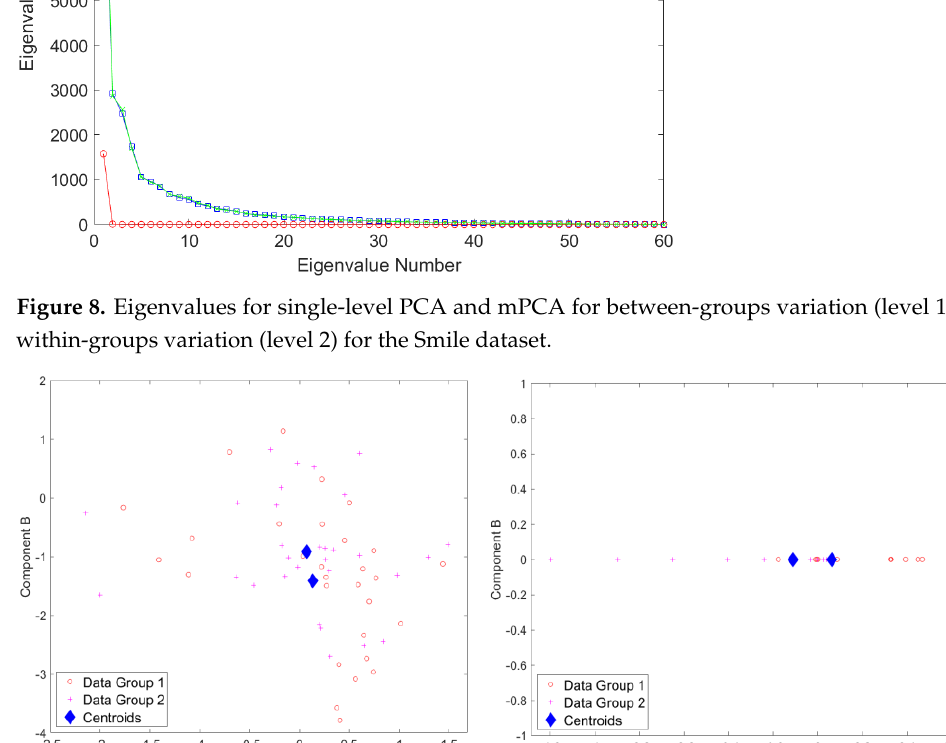
Figure 8. Eigenvalues for single-level PCA and mPCA for between-groups variation (level 1) and within-groups variation (level 2) for the Smile dataset.